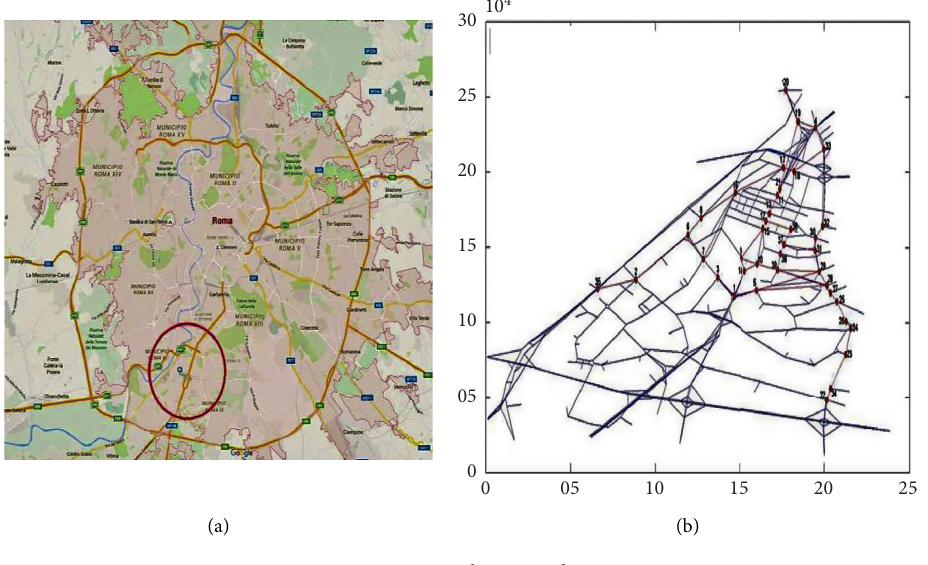
Figure 8: Real case